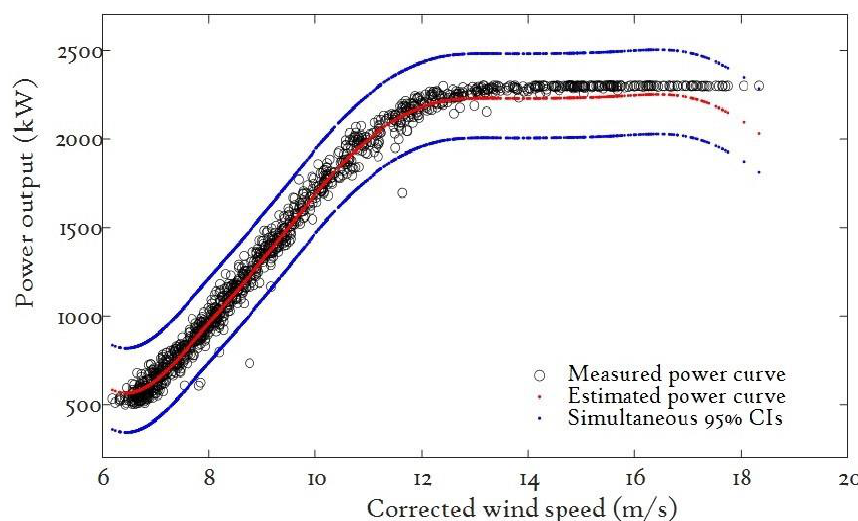
Figure 9. Simultaneous CIs for SVM-based power curve.